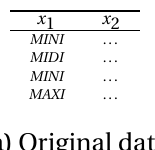
Figure 2. One–hot encoding for x 1 attribute